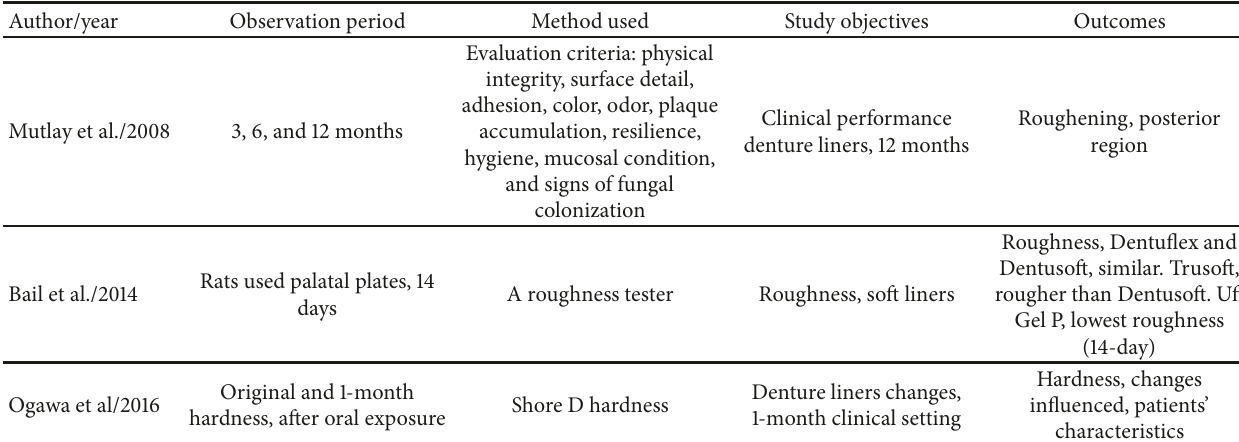
Table 4: Included studies related to in vivo